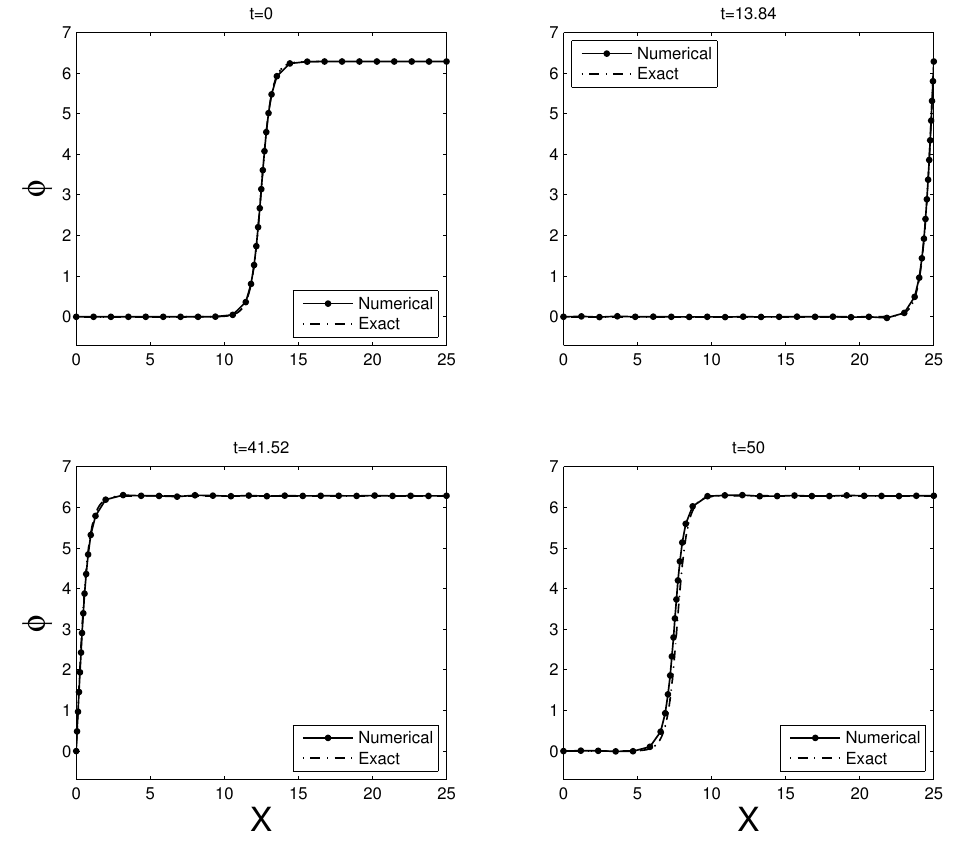
Figure 7. The single soliton solution obtained with the control-theoretic strategy for N = 31: Integration in time was performed using the 4th-order Gauss scheme. Integration with the 4th-order Lobatto IIIA–IIIB yields a very similar level of